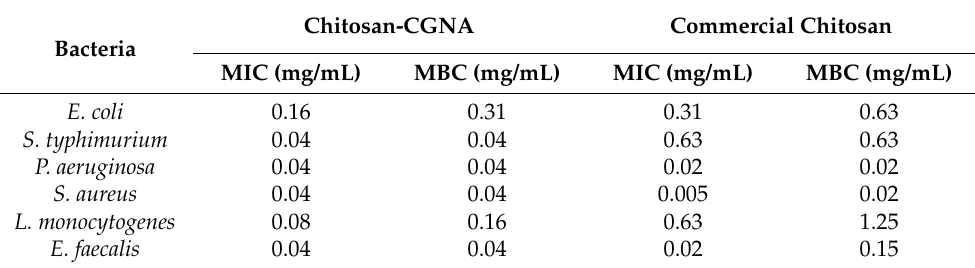
Table 2. Minimum Inhibitory Concentration (MIC) and Minimum Bactericidal Concentration (MBC) of chitosan. Chitosan-CGNA Commercial Bacteria